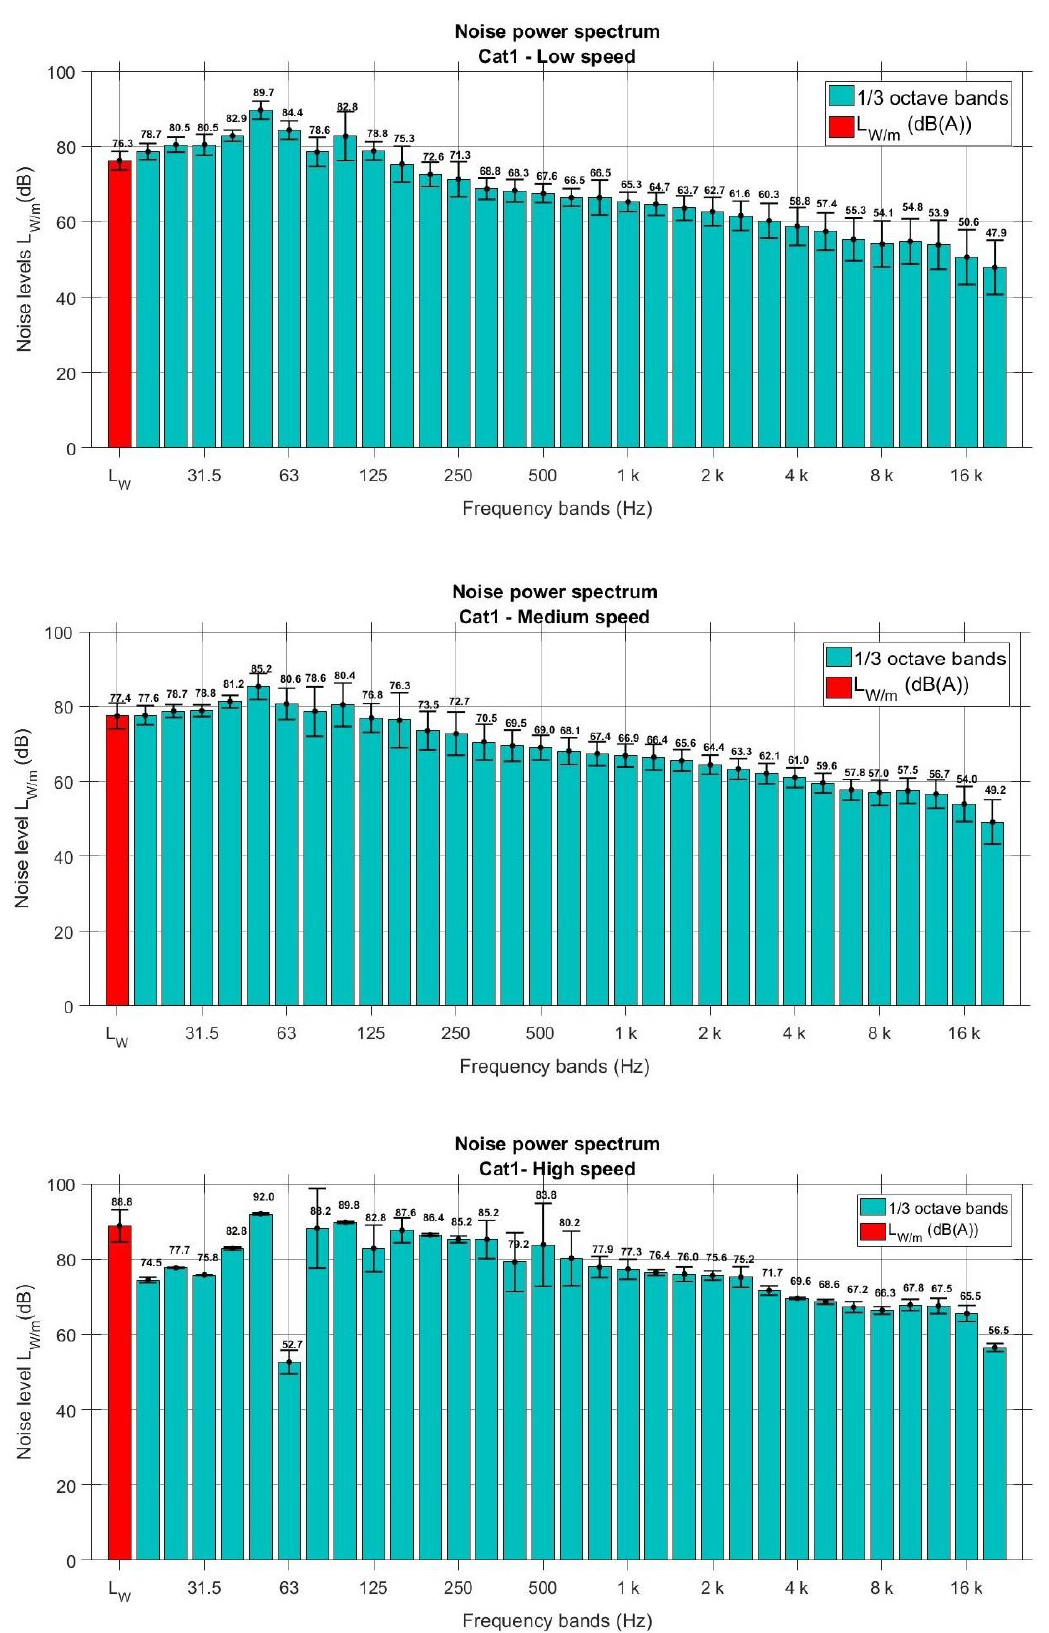
Figure 3. L W/m and 1/3 octave band sound power spectra of Cat1 vessels for low-, medium-, and high-speed classes together with uncertainties.